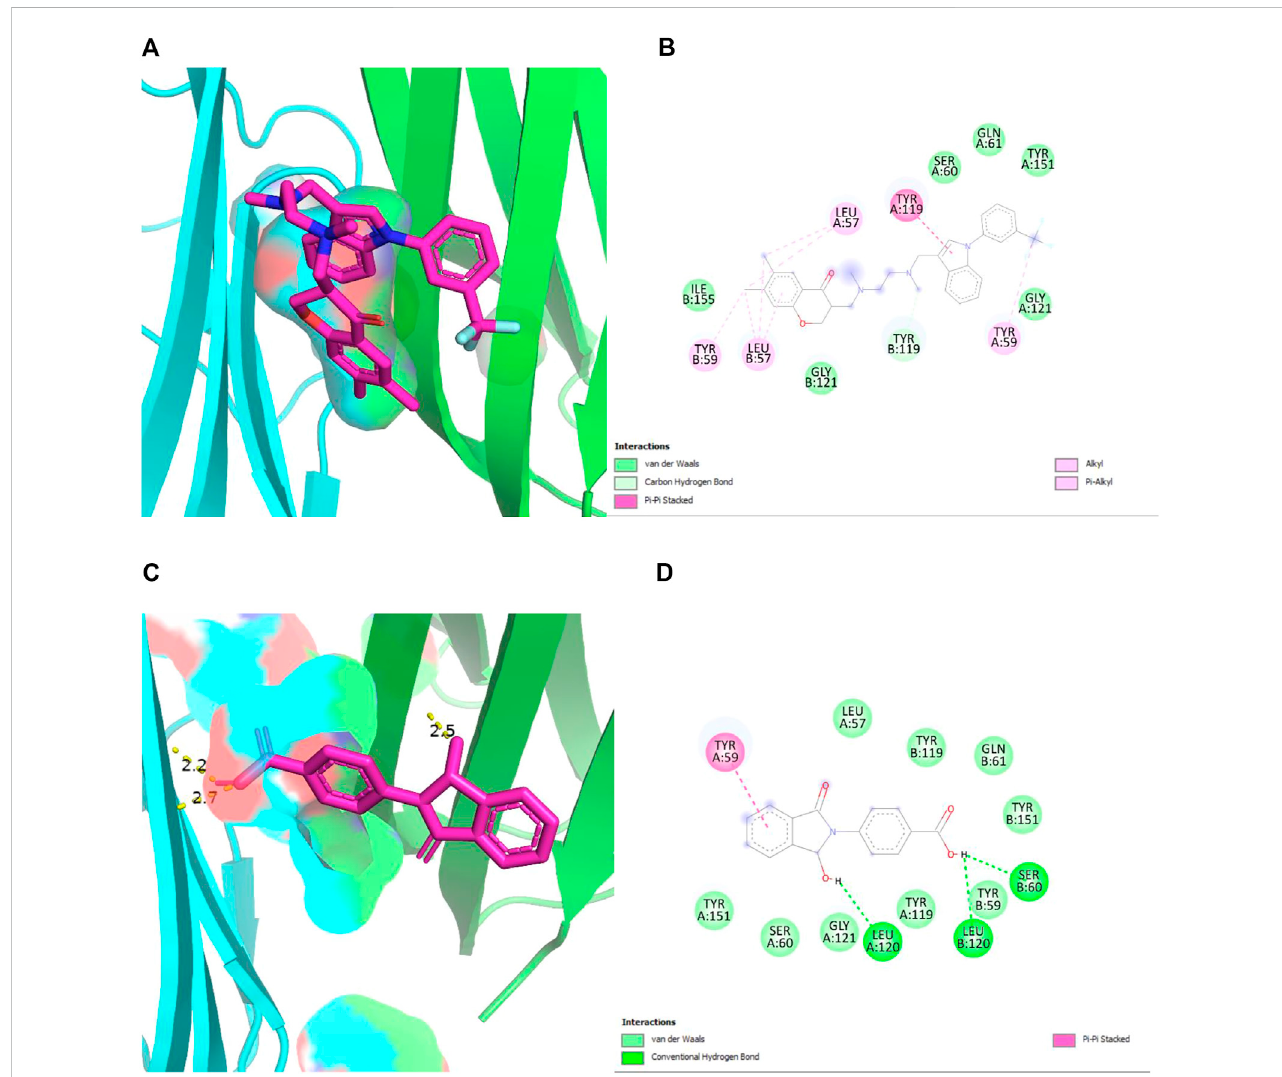
FIGURE 6 (A,B) 2D and3D structures ofTNF- α (PDB 2AZ5) docked withits standard inhibitor. The interaction shows astrong bonding due to thepresence ofmany Van der Waal interactions, with an overall binding energy of − 8.6 kcal/mol. (C,D) 2D and 3D structures of TNF- α (PDB 2AZ5) docked with plant compound, show the lowest binding energy of − 8.2 kcal/mol. The presence of three hydrogen bonds provides stability to the